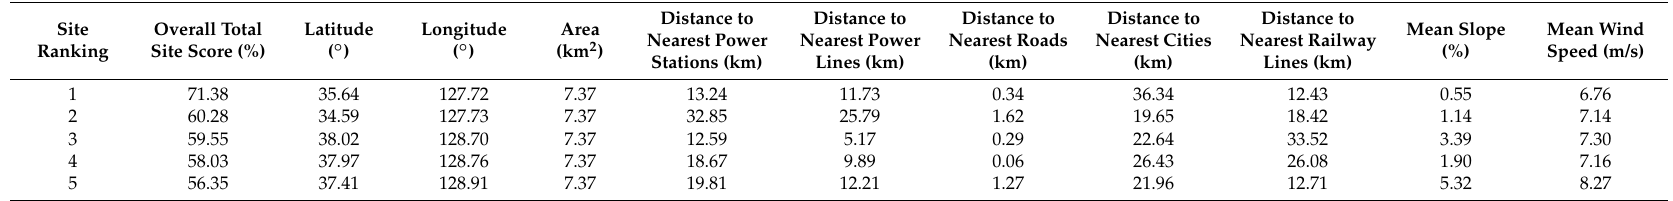
Table 15. Details of Top 5 wind farm sites in South Korea (Scenario